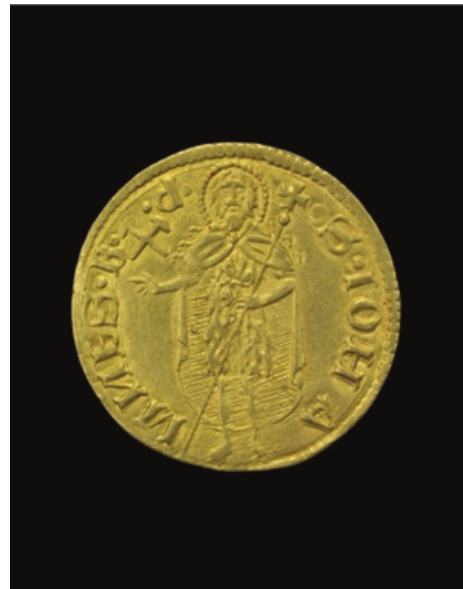
Figure 2: Medieval Florentine florin (BM No.1870, 1101.1). © Trustees of the